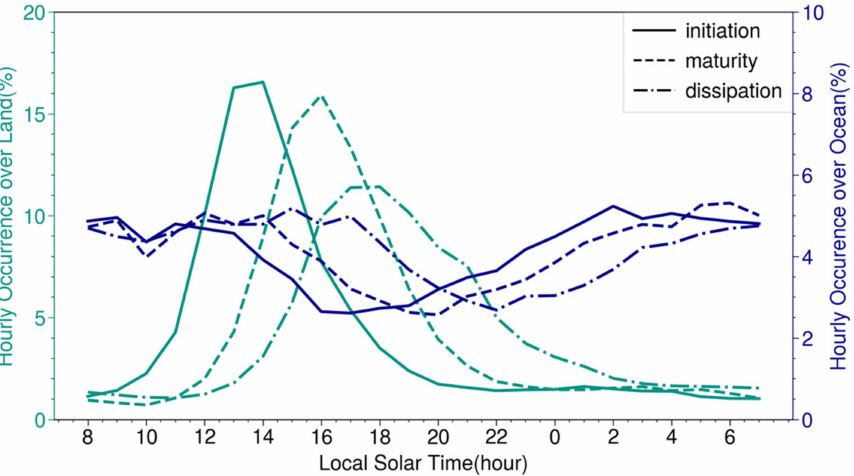
Figure 6. Diurnal variation of occurrence frequencies of convective systems at its initiation, maximum maturity and dissipation stages over land and